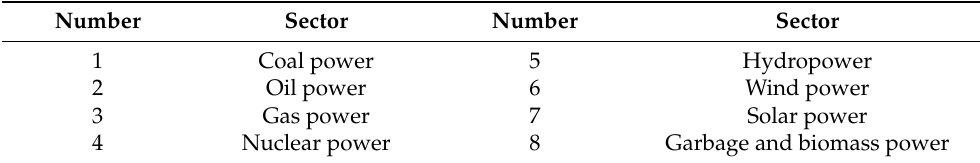
Table 2. The eight power sector technologies in the GD_CGE